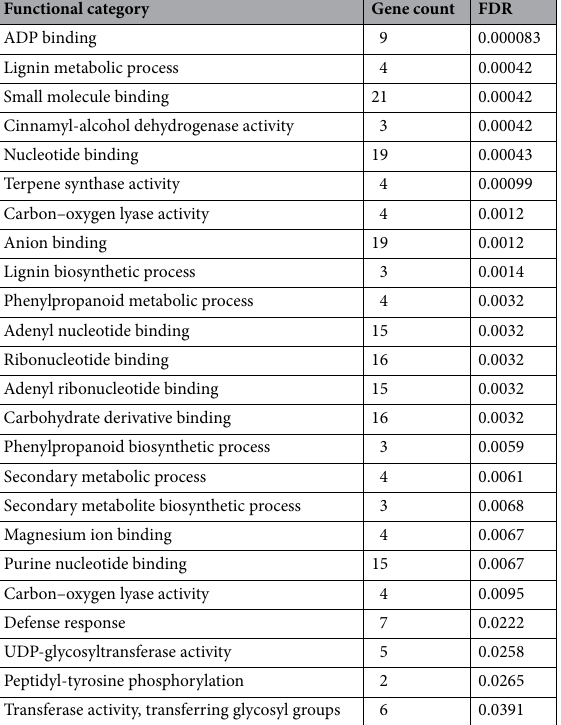
Table 1. Enrichment analysis for the genes that upregulated in Gladiator but downregulated in